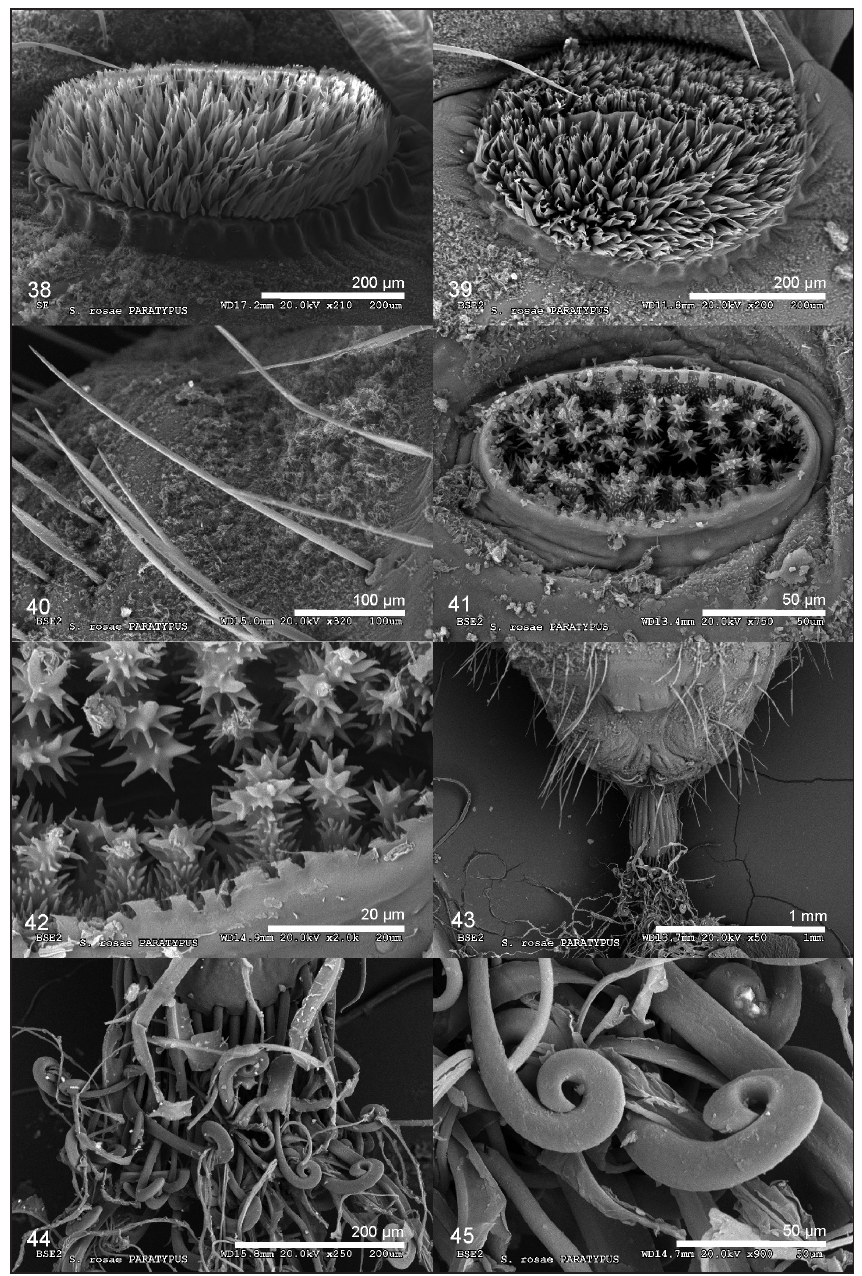
Figures 38–45. Scanning electron microscope images of a pupa of Spialia rosae (Paratype from Puerto de El Cubillo, Cuenca, Central Spain). 38. Lateral view of the mesothoracic tubercle. 39. Upper view of the meso- thoracic tubercle. 40. Detail of the pupal cuticle showing smooth setae with rounded bases. 41. Abdominal spiracle. 42. Detail of the spiny papillae inside the spiracle. 43. Ventral view of the last abdominal segments. 44. Detail of the cremaster. 45. Tips of the cremastral